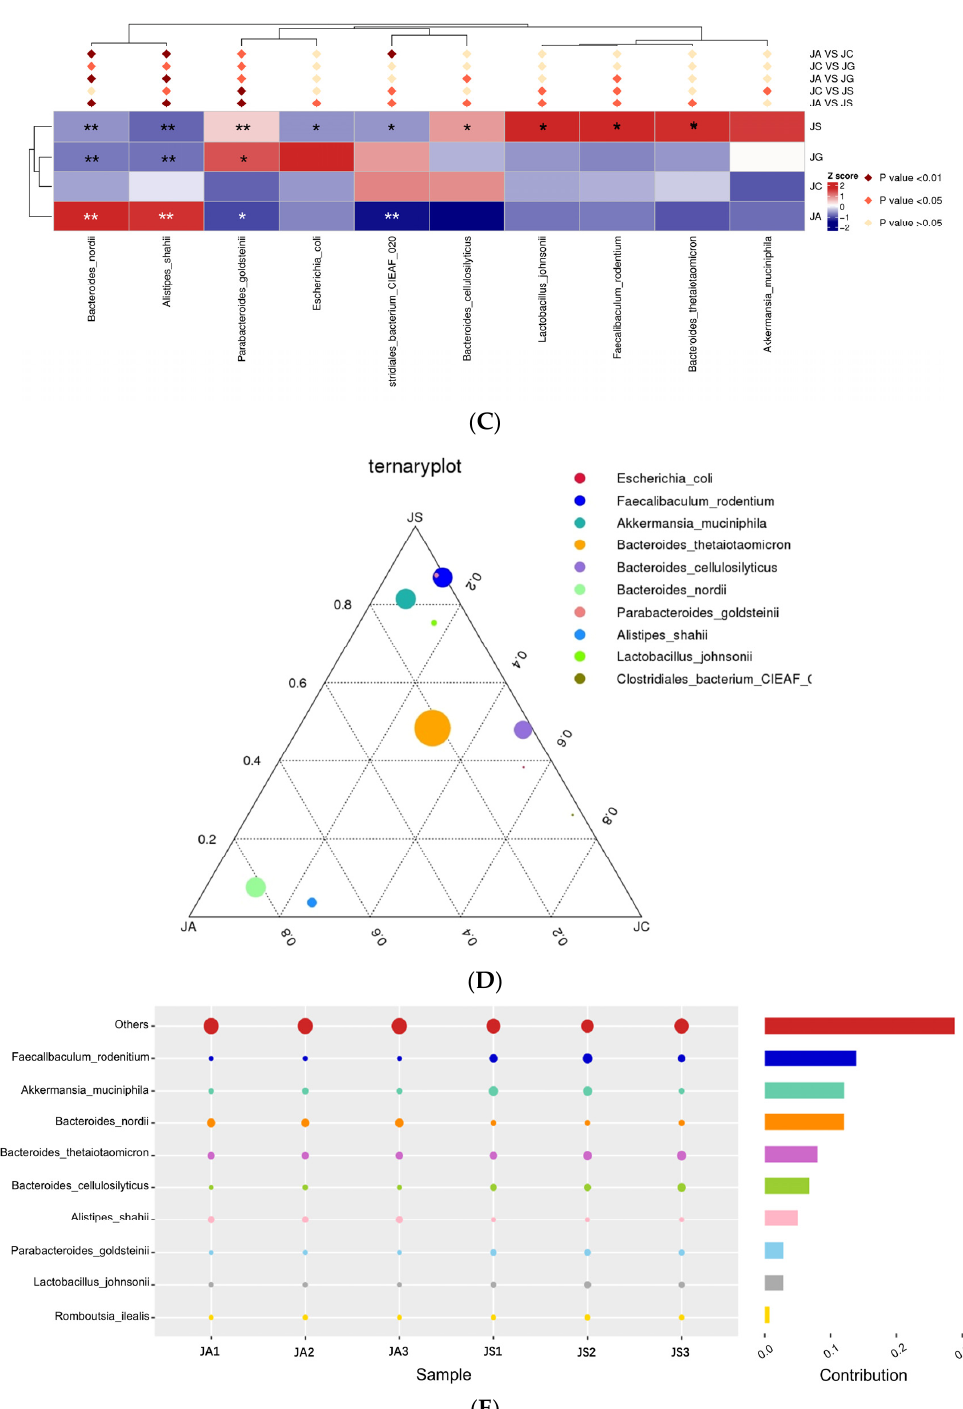
Figure 9. Assessment of intestinal microbiota structure based on metagenomics analysis: ( A ) Structure of intestinal microbiota at the phylum level; ( B ) the distribution of intestinal microbiota in each group at the species level (no others); ( C ) the differences between groups at the species level. Note: Black * in the graph represents the p -value of ALI vs. LP-cs, and white * represents the p -value of ALI vs. control. P -values between other groups are shown on the top of the clustering graph. ** p < 0.01 and * p < 0.05; ( D ) the distribution of dominant strains in the three groups (JC/JA/JS); ( E ) the contribution of strains to the difference in ALI vs. LP-cs by Simper analysis (top 10 strains). n = 3 per group. JC, control; JA, ALI; JS, LP-cs; JG, LP-cs-Gel. * p < 0.05, and ** p <